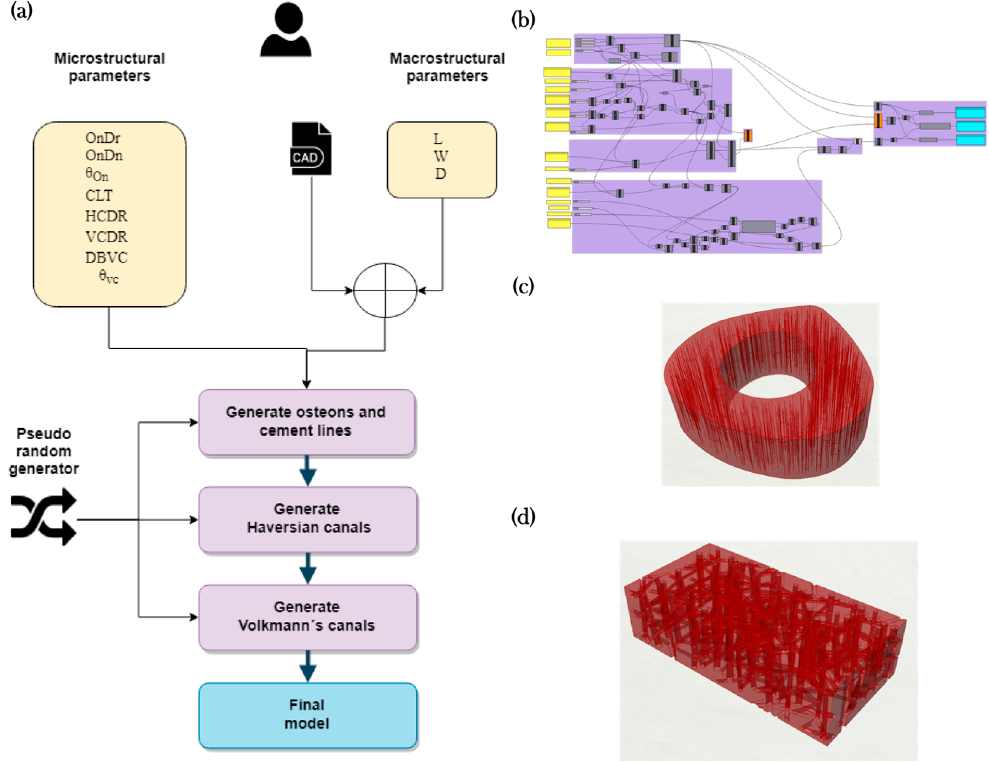
Figure 2. Bone modeling algorithm: ( a ) pseudocode; ( b ) screenshot of the VPL script; ( c ) final model bone shape, and ( d ) example of a model with rectangular prism.